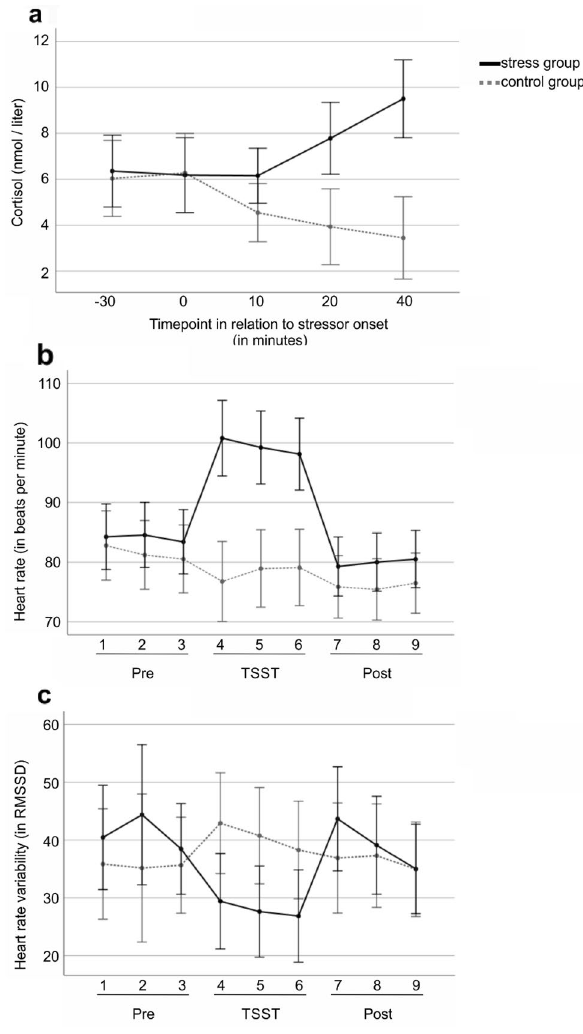
Figure 3. Physiological stress measures. ( a ) Level of salivary cortisol on 5 timepoints throughout the experiment for control and stress group, respectively. Timepoints of measurement were 30 min before stressor onset, at stressor onset, and 10, 20 and 40 min after stressor onset. ( b ) Timeline for HR measurements for control and stress group, respectively. Three sessions (pre-manipulation “pre”, during the manipulation “TSST”, post-manipulation “post”) with three measurements each are shown. ( c ) Time course of HRV measurements in RMSSD throughout the experiment. The RMSSD was calculated in three equally sized time intervals in each of the three sessions “pre”, “TSST”, “post”, resulting in a total of 9 values per participant. Error bars indicate 95% confidence